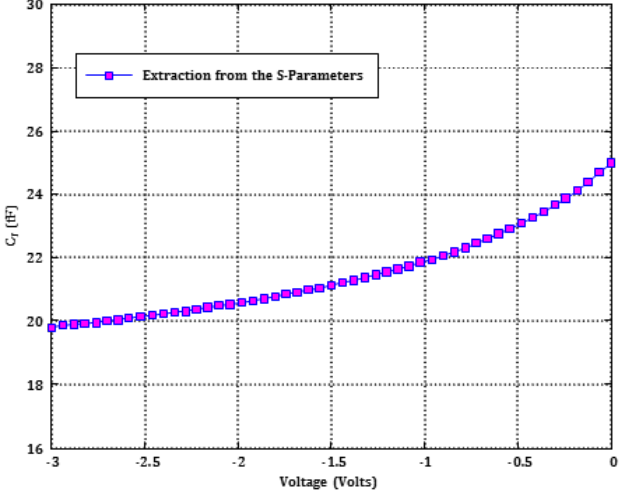
Figure 6. Results for the extraction of total capacitance of the ZBD from scattering parameters .